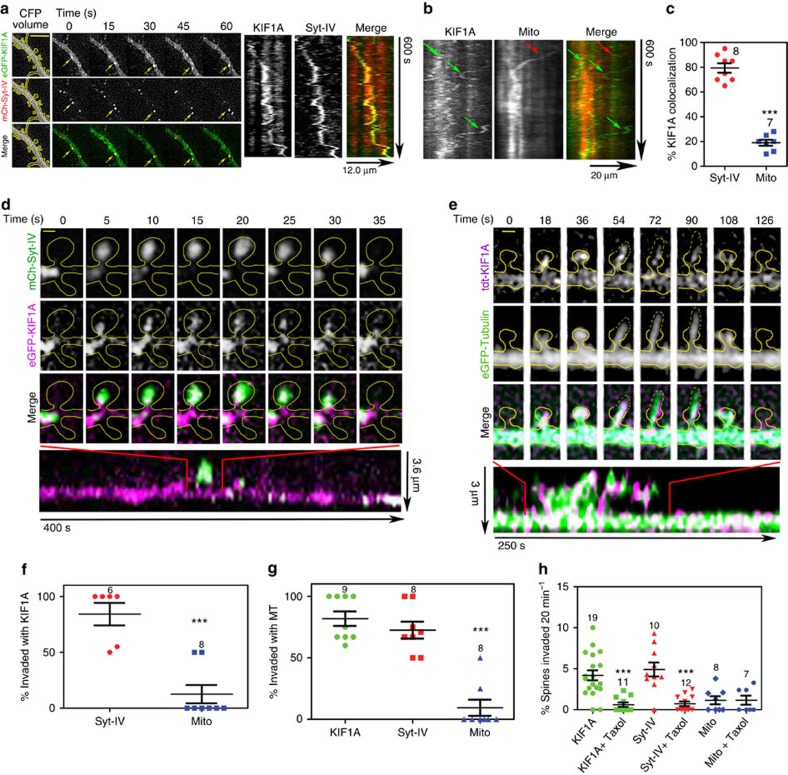
KIF1A dynamically colocalizes with syt-IV and invades dendritic spines along microtubules.(a) eGFP-KIF1A colocalizes with mCherry-syt-IV in the dendritic shaft and moves together over time as detected in time-lapse images and in kymographs (scale bar, 5 μm). (b) Kymographs demonstrating that KIF1A (green arrows) does not colocalize with mitochondria (red arrow) in the dendritic shaft. (c) KIF1A colocalizes with syt-IV significantly more (79.4±3.8%) than with mitochondria (19.0±2.4%) in the dendritic shaft (P=0.0009, n=8, 7). (d) mCherry-syt-IV (green) invades dendritic spines (outlined in yellow from cyan fluorescent protein (CFP) volume fill) simultaneously with eGFP-KIF1A (magenta) for 30 s before both molecules disappear together (scale bar, 1 μm). (e) tdTomato-KIF1A (magenta) invades a dendritic spine (outlined in yellow) during a MT invasion (eGFP-tubulin, green; scale bar, 1 μm). (f) Syt-IV invades dendritic spines simultaneously with KIF1A (84.2±10.0%, n=6) of the time and significantly more than with mitochondria (12.5±8.2%, P=0.0032, n=8). (g) KIF1A and syt-IV invade dendritic spines 81.8±5.9% (n=9) and 72.5±6.8% (n=8) of the time with MTs, respectively, while mitochondria invade with MTs a significantly lower percentage of time (9.4±6.6, P=0.0003, n=8). (h) Low dose (10 nM) application of Taxol significantly reduces the percentage of spines invaded over a 20 min time period by both KIF1A (from 4.2±0.6 to 0.6±0.3%, P=0.0002, n=19, 11)) and syt-IV (from 4.9±0.9 to 0.73±0.28%, P=0.0001, n=10, 12), but not mitochondria (from 1.1±0.5 to 1.1±0.6, P=0.9999, n=8, 7). Asterisks indicate significance relative to controls (*P<0.05, **P<0.01, ***P<0.001). Numbers above scatter plots indicate number of cells analysed per condition, from at least three replicate experiments. For c,f, a Student's t-test was used to determine significance. For g,h, a one-way analysis of variance (ANOVA) with Tukey's post hoc test was used. All graphs show mean±s.e.m.